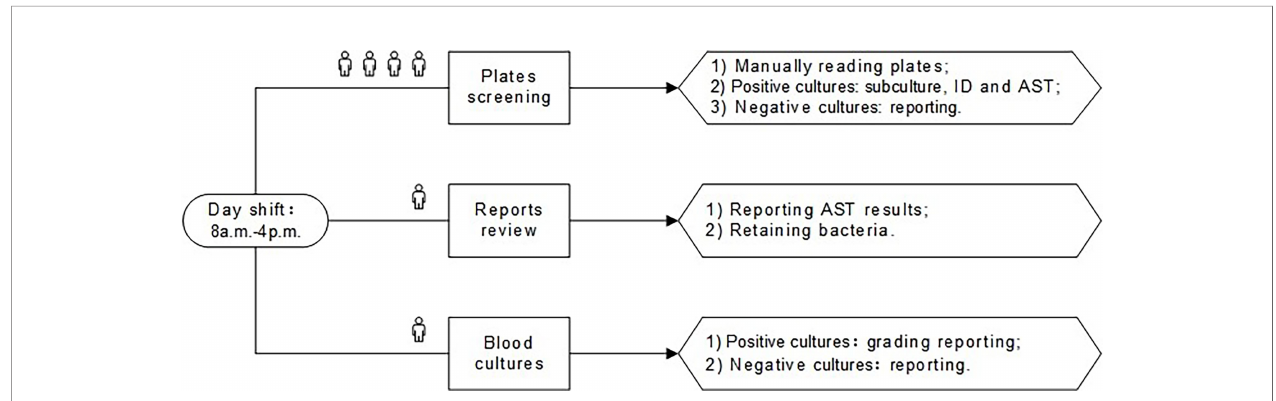
FIGURE 1 | The day shift of pre-TLA: four people for plates screening, one person for reports review, and one person for blood cultures. ID, identi fi cation; AST, antimicrobial susceptibility testing; TLA, total laboratory